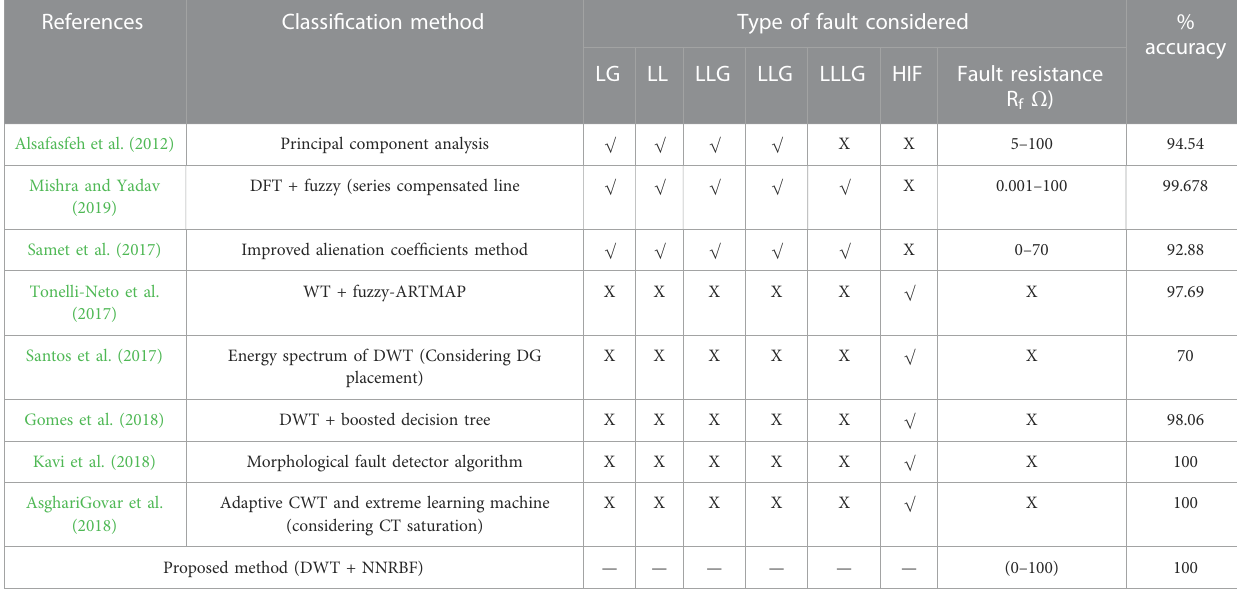
TABLE 3 Comparison on various methods.